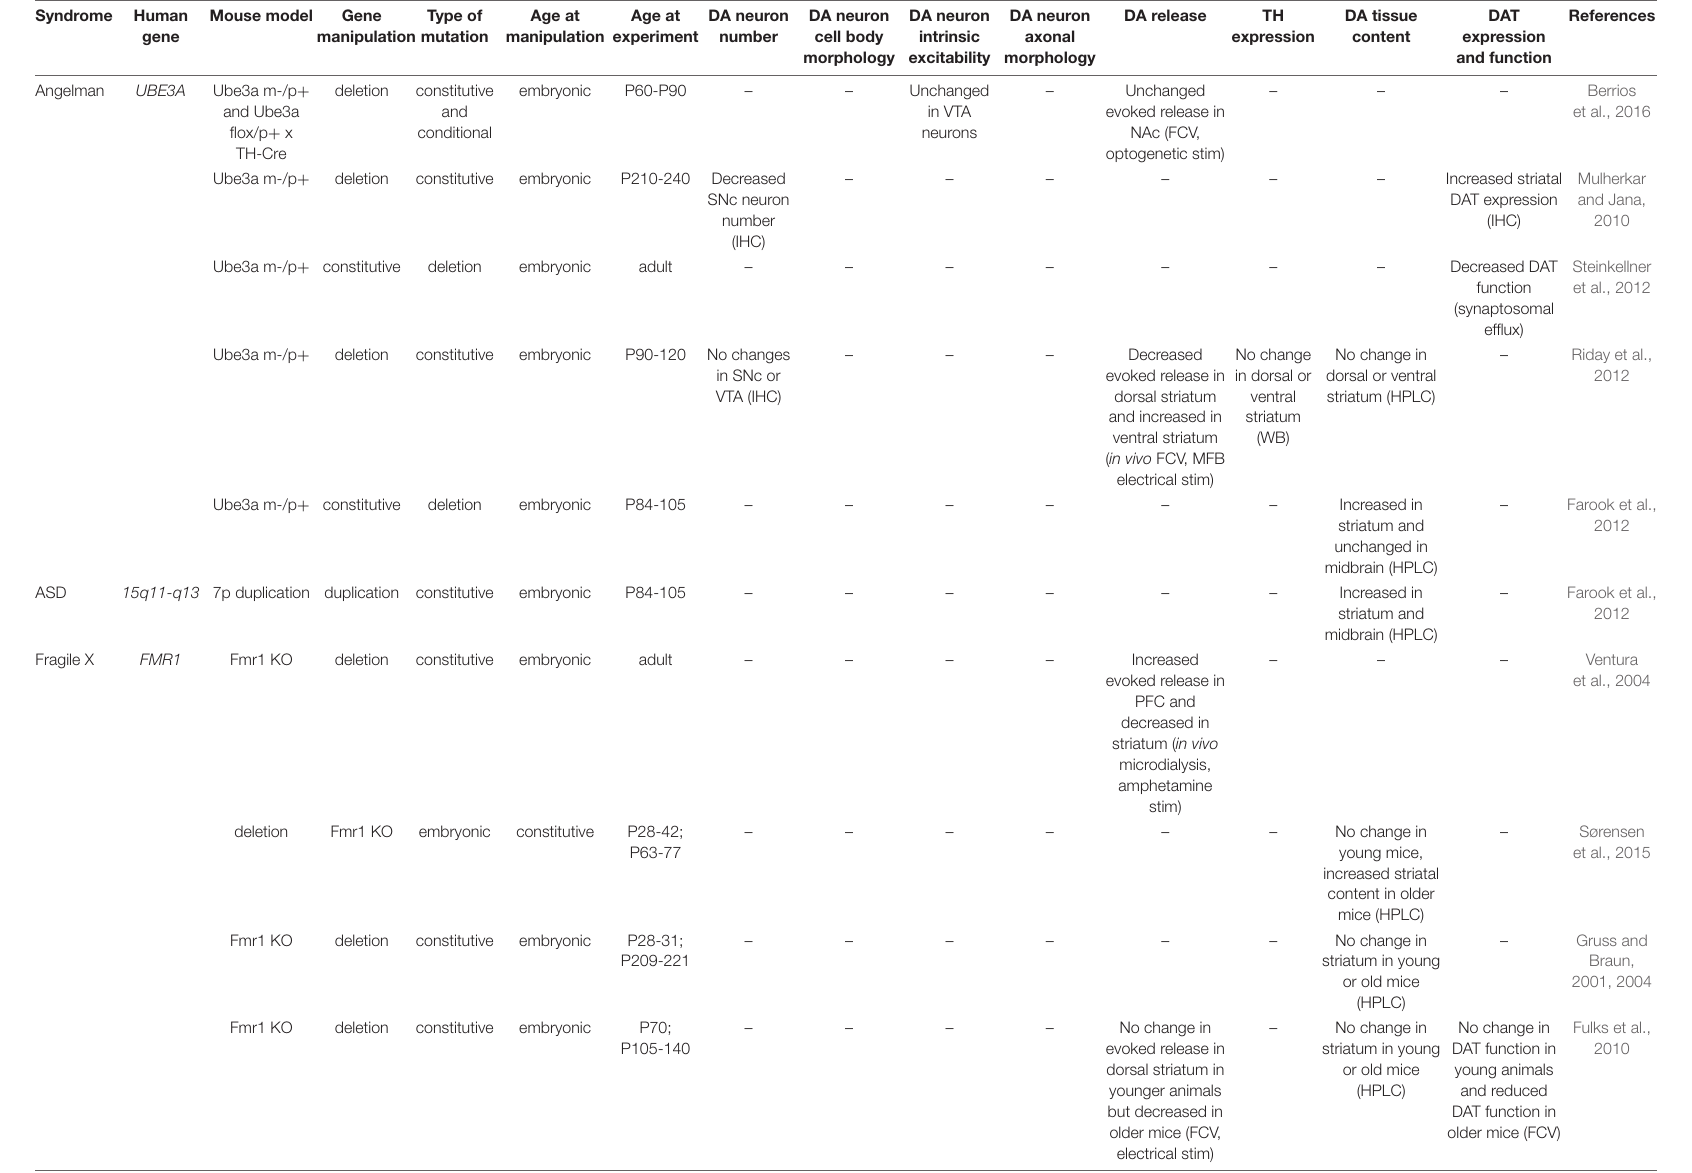
TABLE 1 | Summary of DA neuron phenotypes in mouse models of syndromic autism spectrum disorders. Syndrome Human